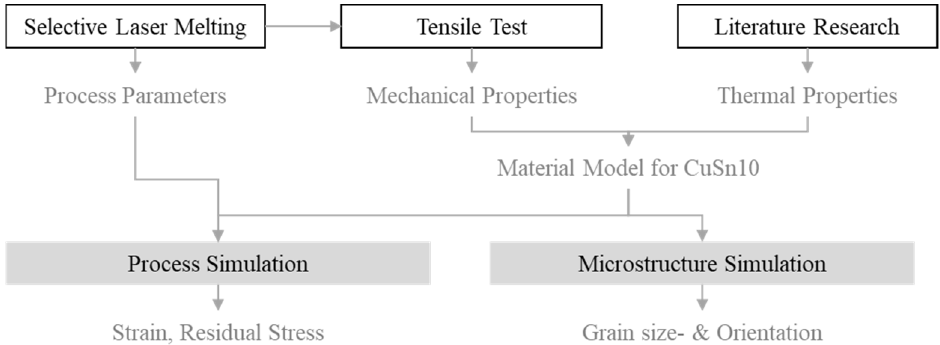
Figure 1. Schematic representation of the experimental plan.